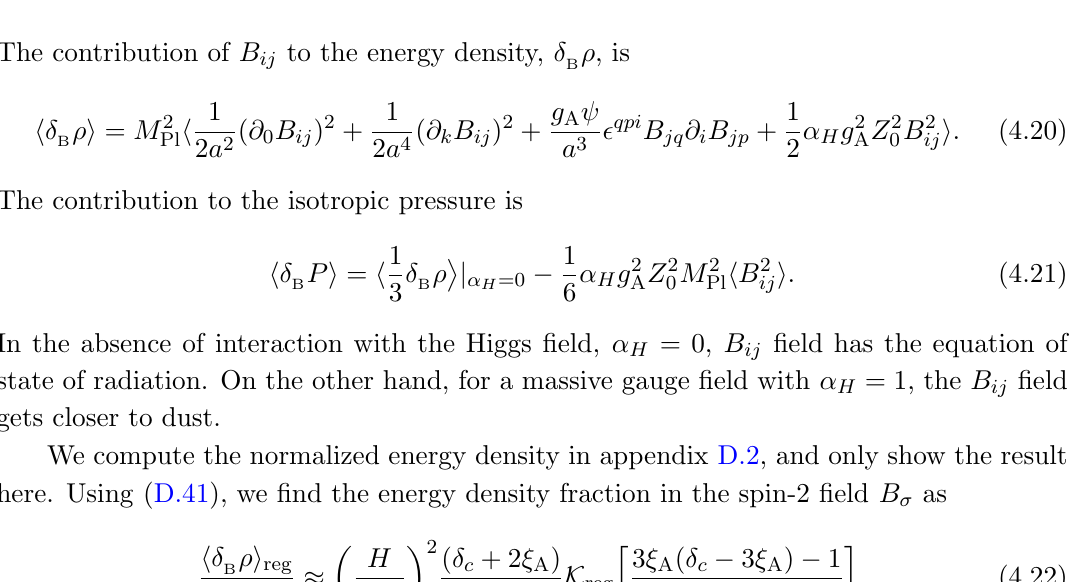
Figure 7 . The energy density of the spin-2 (cid:12)eld, (cid:14) of (cid:24) Z . The dashed lines show negative 0